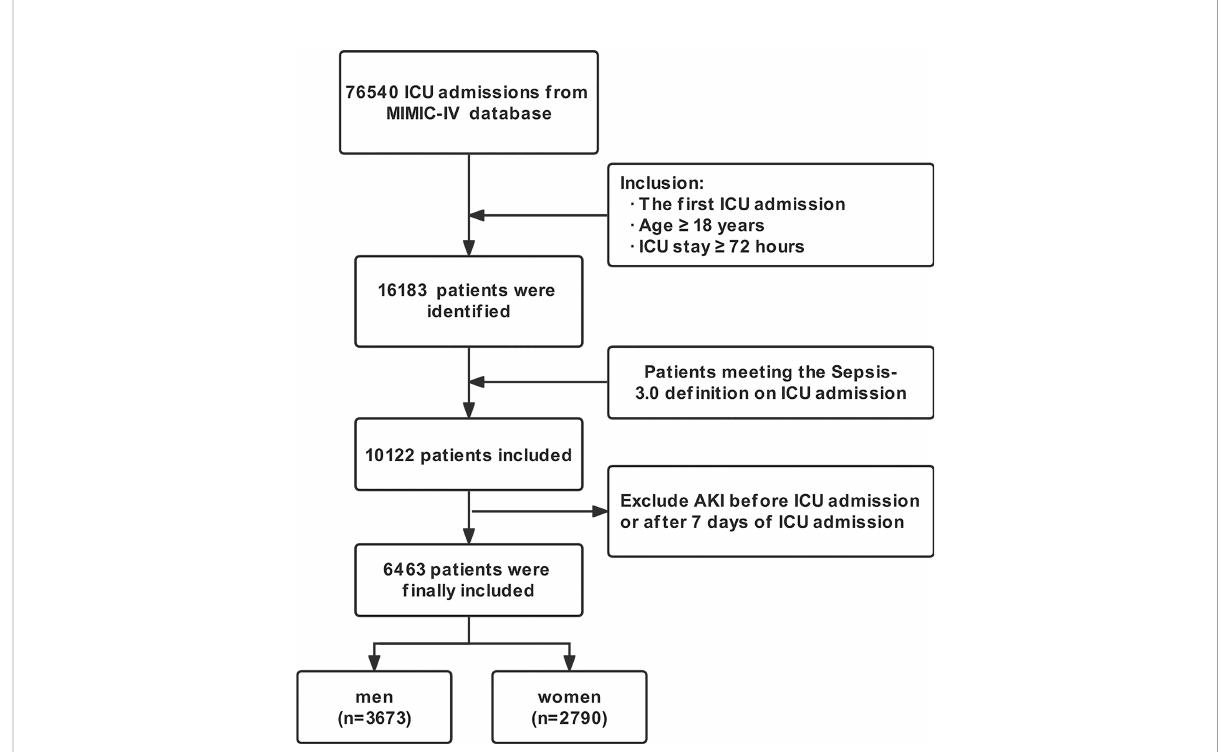
FIGURE 1 Flow chart of this study. MIMIC-IV, Medical Information Mart for Intensive Care IV database; ICU, Intensive care unit; AKI, Acute kidney